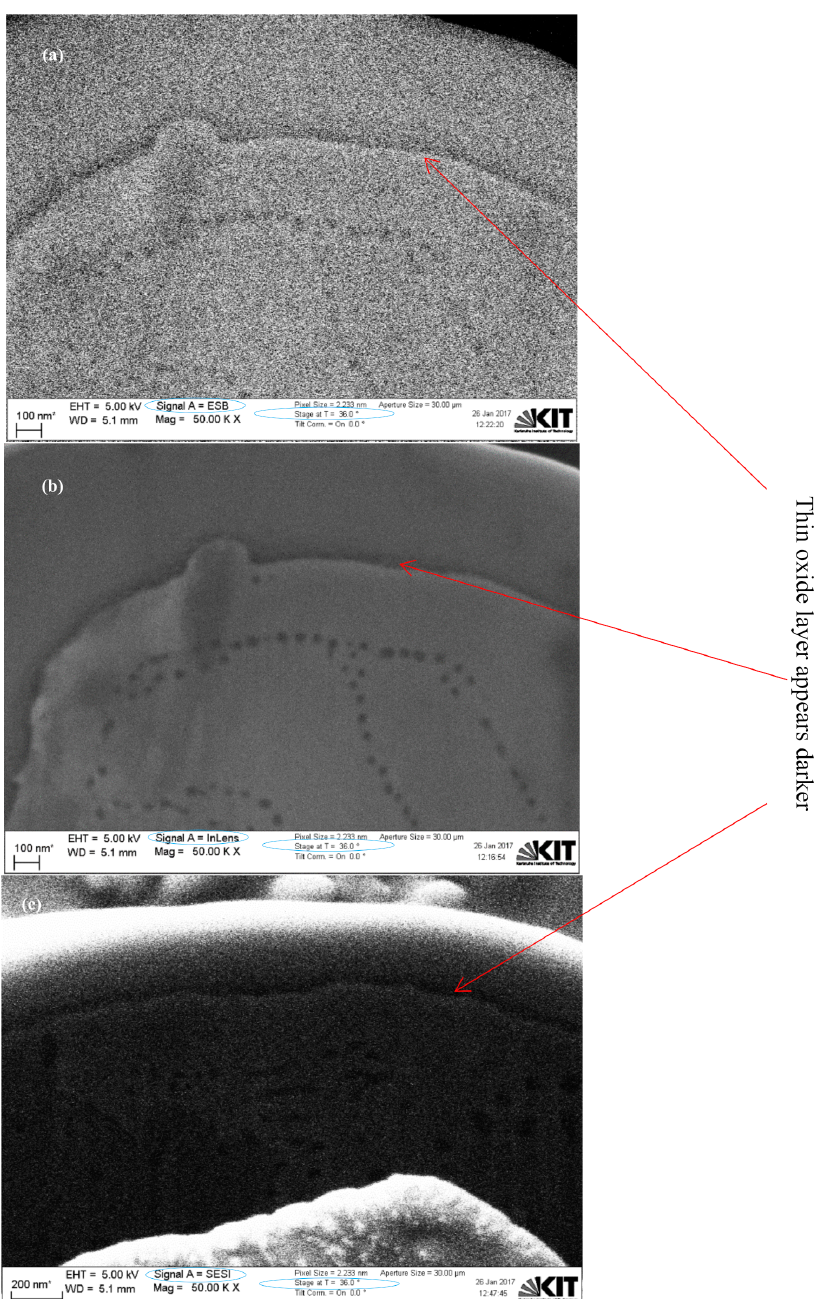
Figure 11. Dual FIB-SEM images for sectioned Cu particles with 10 µ m APS using three different detector modes: ( a ) BSE, ( b ) InLens, and ( c )